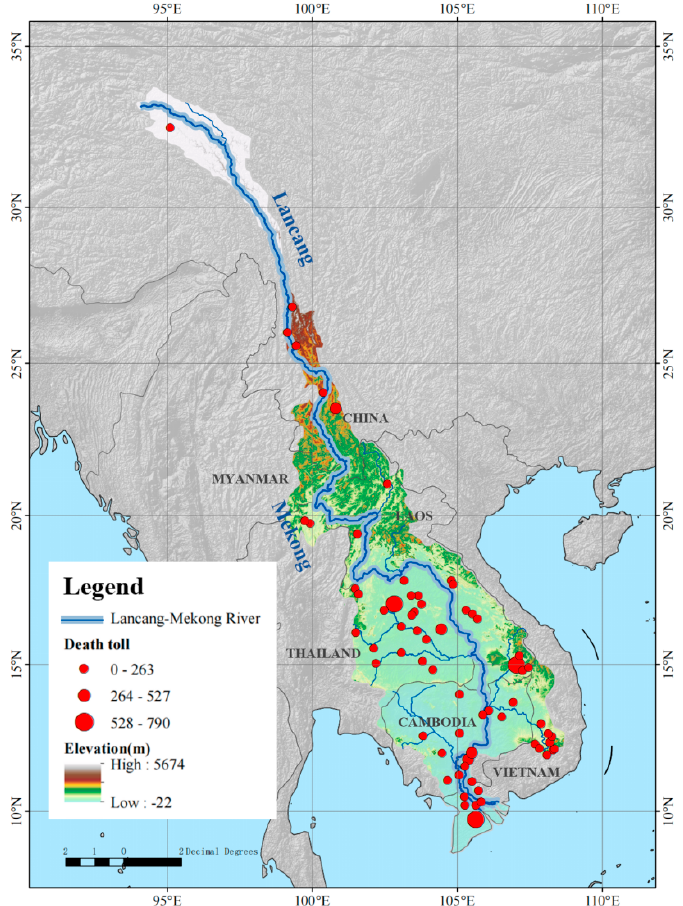
Figure 1. Spatial distribution of flood disaster events in Lancang-Mekong River basin (1985–2019) Data source: EM-DAT International Disaster database (https://www.emdat.be/ (accessed on 17 April 2020).